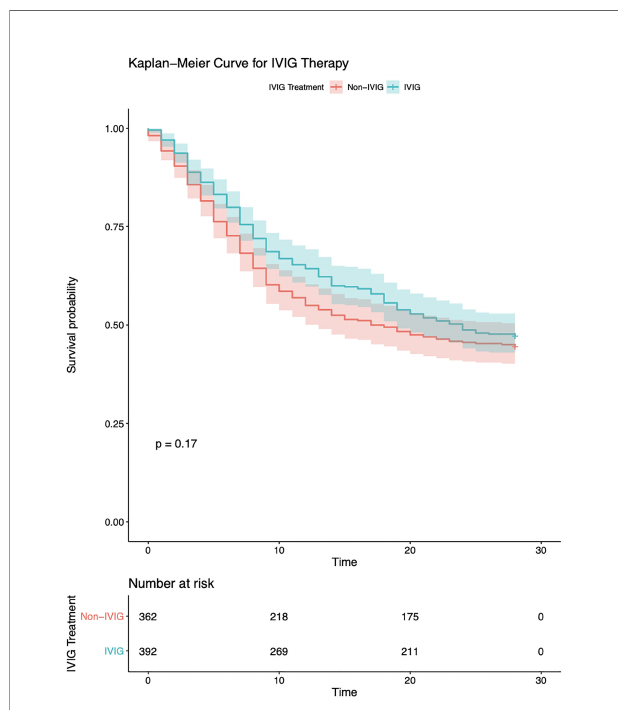
FIGURE 1 | Kaplan – Meier analysis for 28-day survival of the IVIG and non- IVIG groups. IVIG, intravenous immunoglobulin.